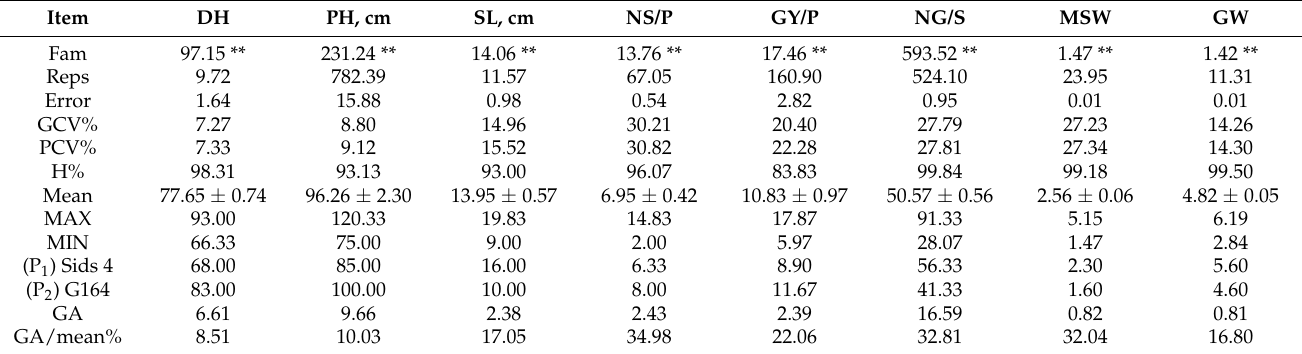
** Significant at 0.01 level of probability. GA = expected genetic gain from selection superior 20 families, DH = days to heading, SL= spike length, NS/P = number of spikes/plant, NG/S = number of grains/spike, MSW = mean spike weight, GW = 100-grain weight, GY/P = grain yield/plant.